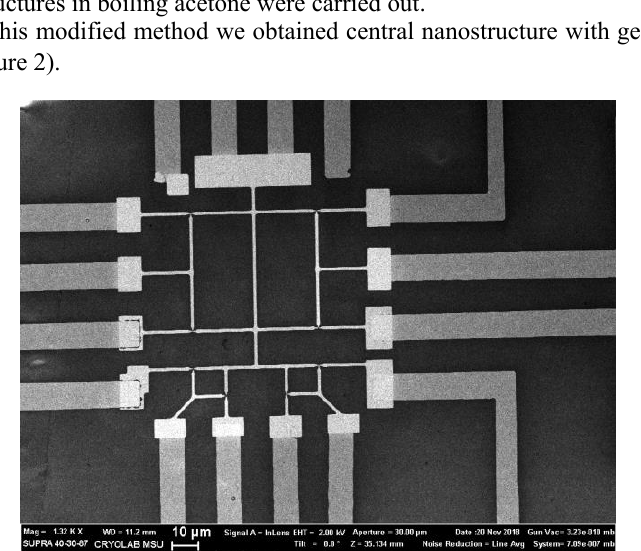
Fig. 2. SEM image of the obtained nanostructure placed between IDTs of acoustic delay line. This structure consisted of eight nanowires. Each nanowire was 180nm in length, 20nm in width and with thickness about 77nm (chromium -7nm, gold-50 nm, and titanium- 20